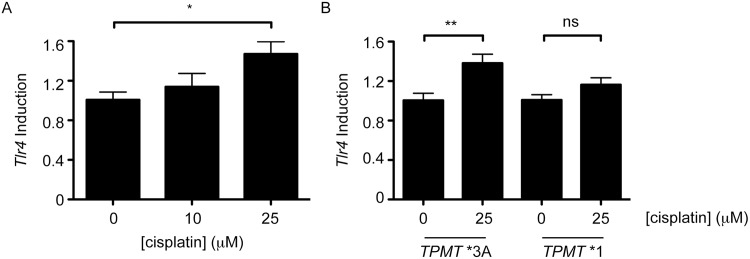
TPMT influences response of a cisplatin biosensor in a murine inner ear cell line.A, Tlr4 expression was quantified in HEI-OC1 cells treated with the indicated concentrations of cisplatin. Tlr4 expression increased with increasing cisplatin and served as a cisplatin biosensor. B, HEI-OC1 cells expressing TPMT*1 or TPMT*3A were treated with 25 μM cisplatin or left untreated and relative expression of the cisplatin biosensor was determined. Data are presented as the mean and standard error of the mean for nine replicates for untreated cells (3 independent experiments) and 6 replicates for cisplatin treated cells (2 independent experiments). *, ** and ns denote P < .05, P < .01 and not significant, respectively using one-way ANOVA with Tukey post-test analyses.